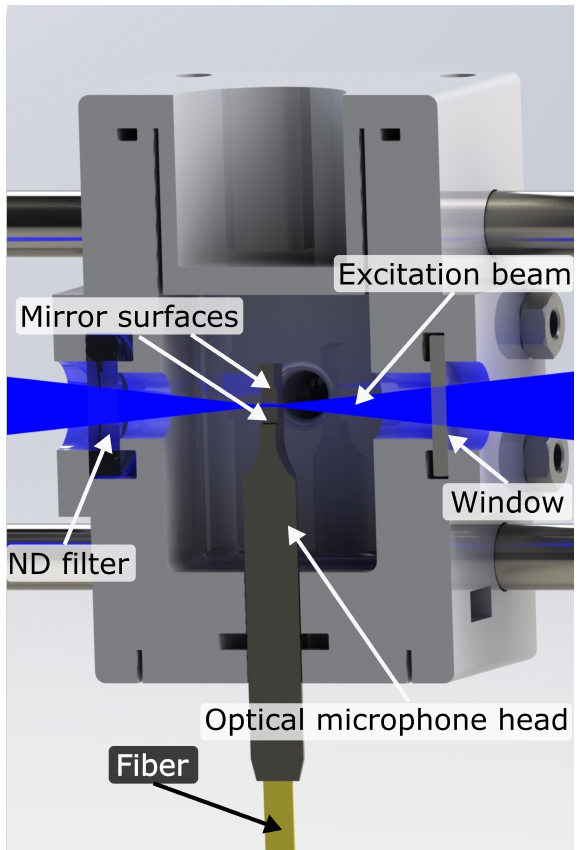
Figure 1. Cut through the 3D-printed cell, carrying the head of the optical microphone. Excitation laser beam is shown in blue. The probe beam is reflected within the microphone cavity between the top and bottom mirror